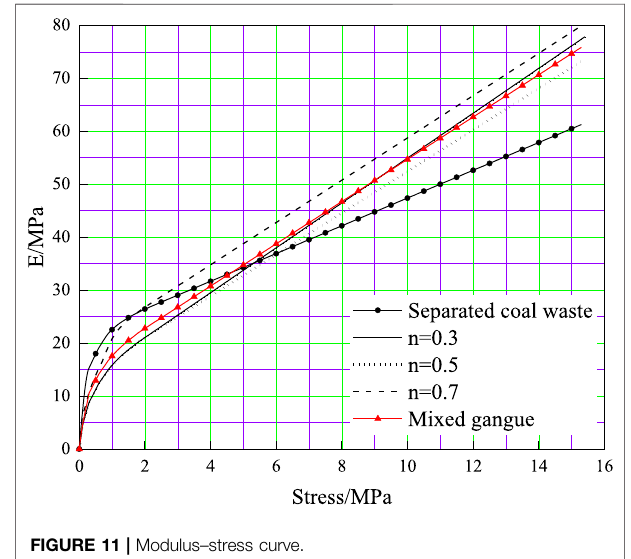
FIGURE 11 | Modulus – stress